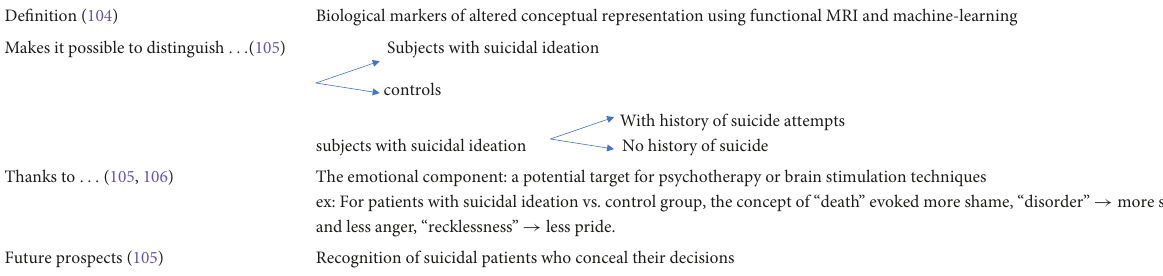
TABLE 2 Neural signatures.